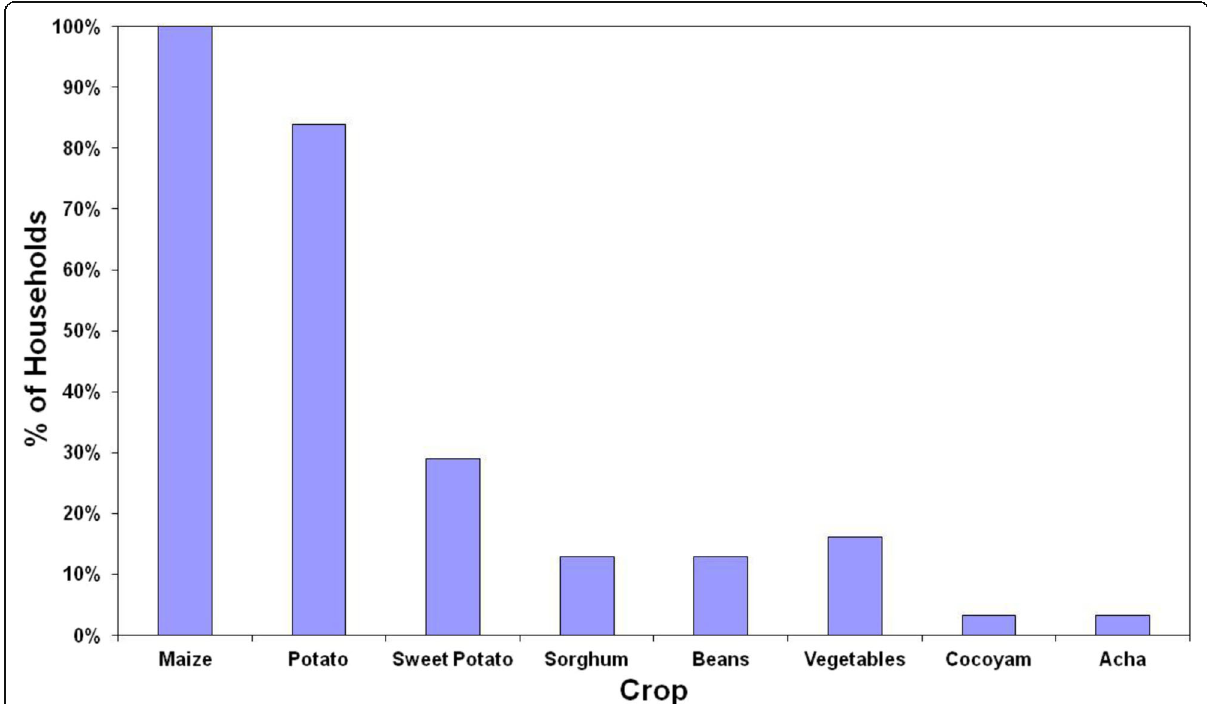
Figure 2 Crops grown by households